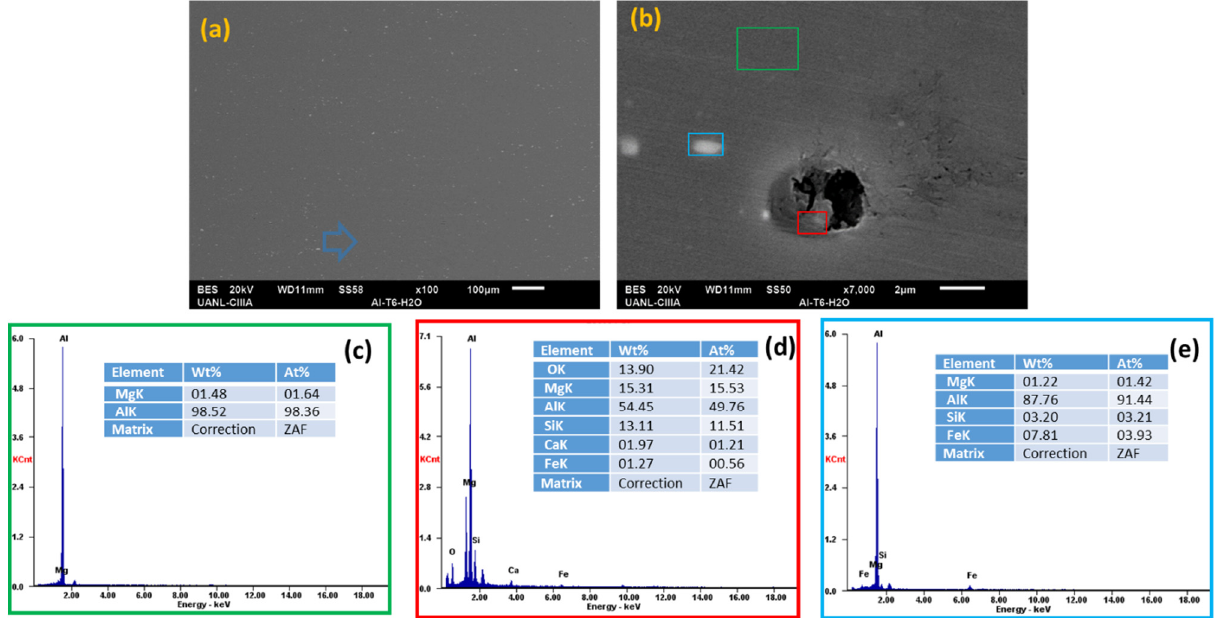
Figure 18. SEM-EDS surface micrographs of Al-6061 ( a , b ) alloys in H 2 O solution and EDS spectrum analysis: ( c ) green box, ( d ) red box, and ( e ) blue box.